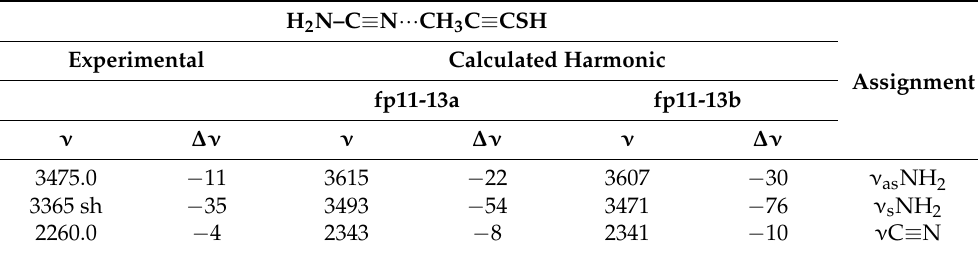
Table 5. Wavenumbers and wavenumbers shifts ( ∆ ν = ( ν comp − ν mon )) (in cm − 1 ) calculated and observed for the H 2 N–C ≡ N ··· CH 3 C ≡ CSH complex in solid argon 1 .